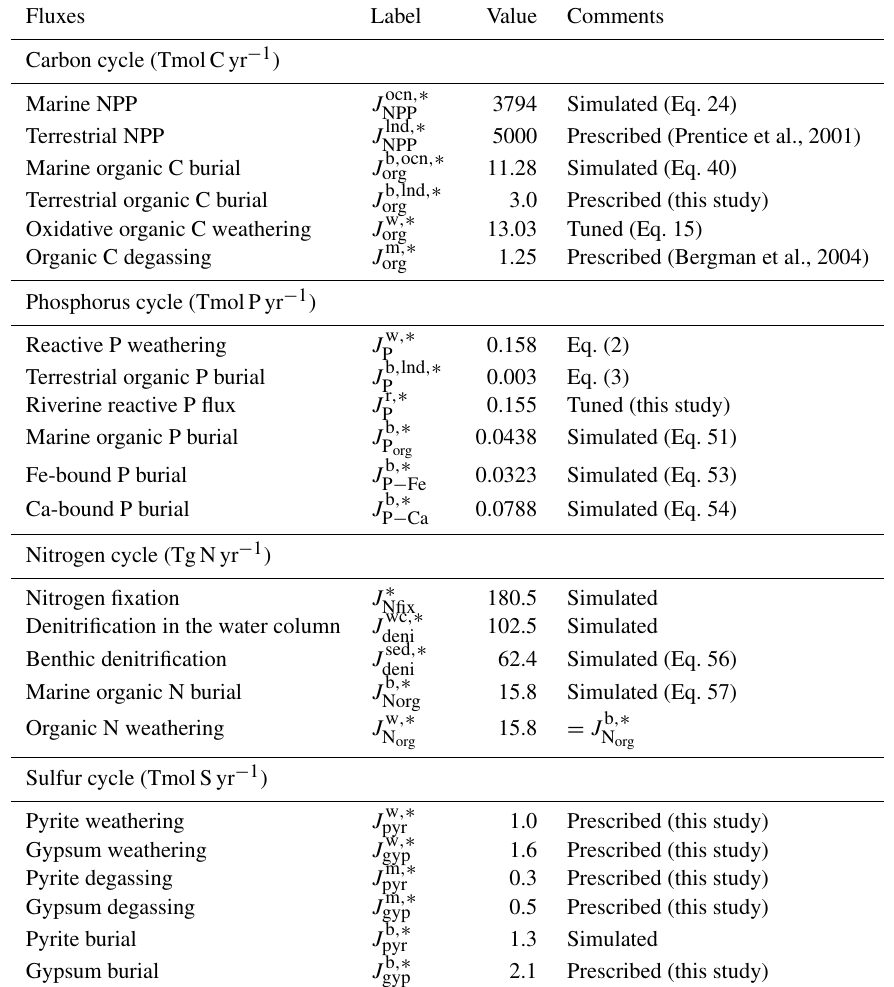
Table 2. Key biogeochemical fluxes obtained from the reference run. * denotes the reference value. Tmol = 10 12 mol, Tg = 10 12 g. Fluxes